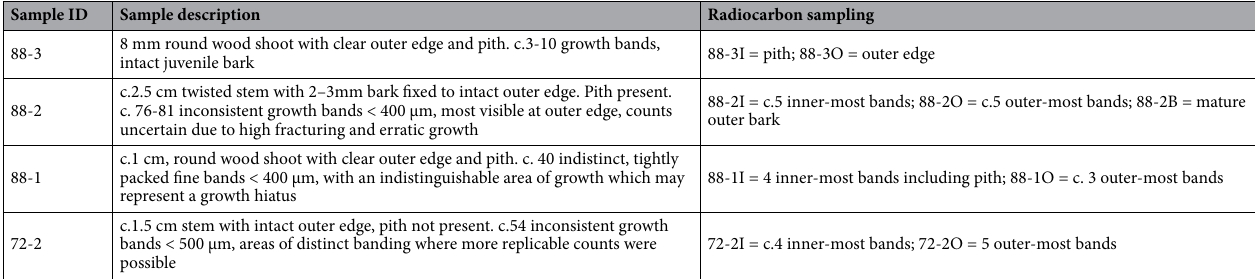
Table 2. Description of sub-samples taken from the Therasia olive shrub, growth band counts and associated radiocarbon